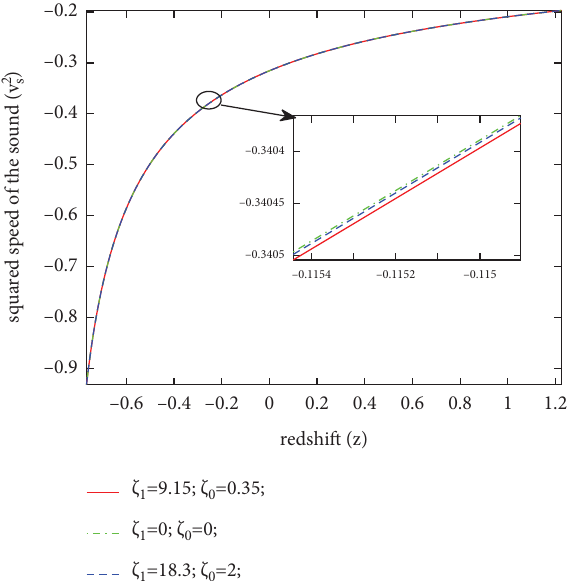
Figure 22: Squared speed of sound ( v 2 ) versus redshift ( z ) for BT-II.